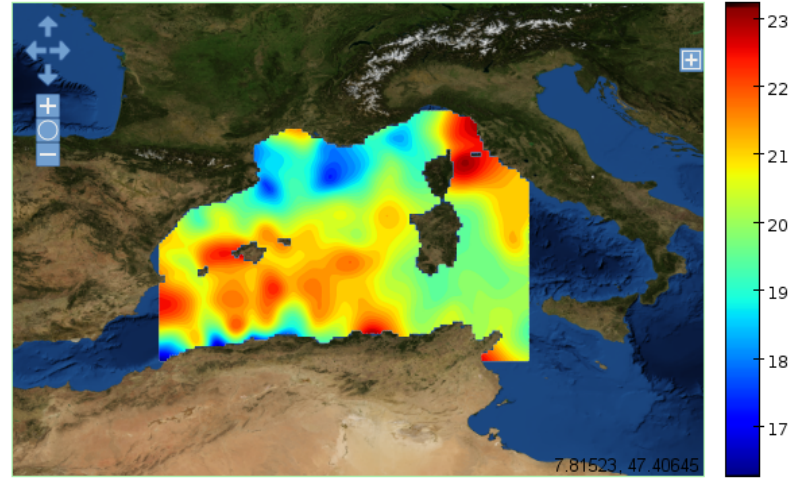
Fig. 5. Analyzed surface temperature of the western Mediterranean Sea with Diva-on-web.